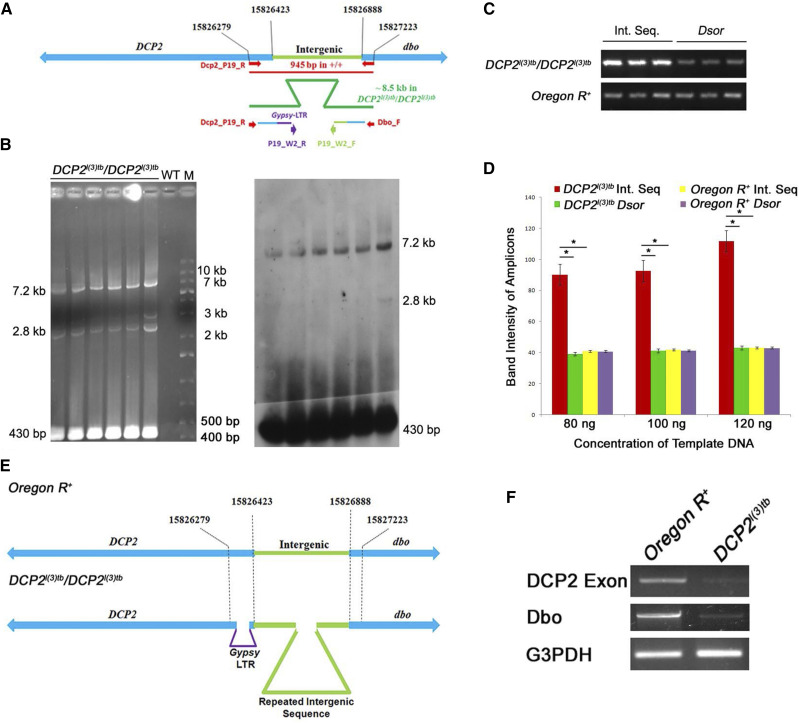
The DCP2l(3)tb genome harbors Gypsy-LTR like sequence in 5′UTR coding region of DCP2 and expansion of adjacent upstream intergenic AT-rich sequence along with low expression of the neighboring gene, dbo. Gel electrophoretogram showing PCR amplification profile obtained by the primers used (P19_W2_R and P19_W2_F) for the “second step” of walking (B). The alignments of the sequences uncovered in the “first step” are shown as thin lines colored as per homology with the wild type sequence. The region amplified here lies subsequent to the sequence uncovered by the initial primers (A; Dbo_F and Dcp2_P19_R, shown in red arrows). Mentioned alongside the electrophoretogram are the semi-logarithmic estimates of the amplicon size. Shown alongside is the blot of the same hybridized with the probe generated from the ∼430 bp amplicon. Semi-quantitative PCR to detect change in copy number of the intergenic region in the DCP2l(3)tb genome (C) shows increased amplification of the intergenic sequence in DCP2l(3)tb genome as compared to the Dsor (control) amplicons in both the genomes. Shown in D is a histogram comparing the fluorescence intensity of PCR amplicons obtained from amplification of the intergenic sequence and the control sequence from the DCP2l(3)tb genome and the wild type genome. The schematic in E shows the architecture of the mutant allele, DCP2l(3)tb based on the results obtained from fine mapping. Semi-quantitative RT-PCR analyses of transcription from DCP2 and dbo in the wild type and DCP2l(3)tb homozygotes (F) shows decreased titer of mRNA from both genes in the tumorous individuals.